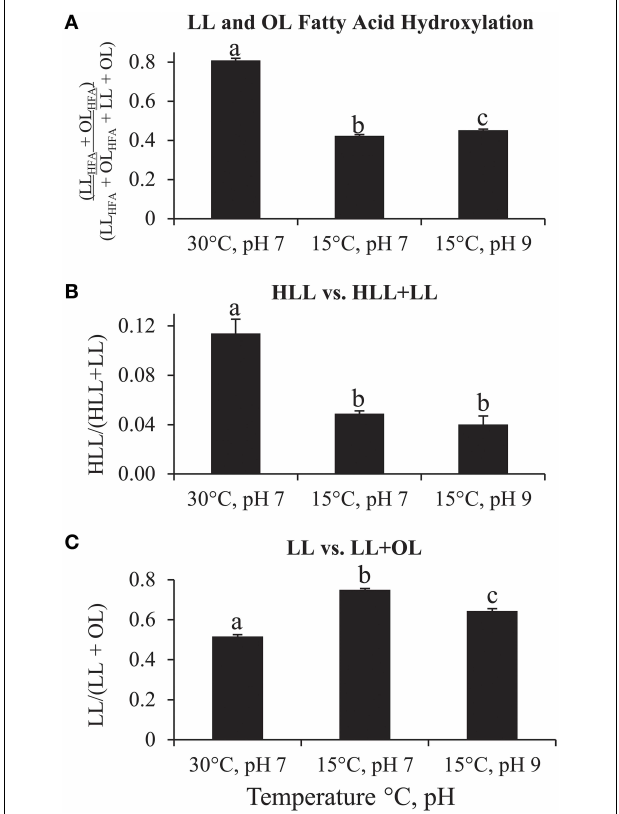
FIGURE 4 | Changes in amino acid-containing IPL abundance ratios based on HPLC-ESI/IT/MS chromatogram base peak area of each lipid group in Pseudopedobacter saltans lipid extract under 30 ◦ C/pH 7, 15 ◦ C/pH 7, and 15 ◦ C/pH 9 growth conditions. (A) Ratio of total fatty acid hydroxylated lysine and ornithine lipids (LL HFA + OL HFA ) to total hydroxylated plus total unhydroxylated fatty acid lysine and ornithine lipids (LL HFA + OL HFA + LL + OL); (B) Ratio of total hydroxylysine lipids (HLL) to total HLL plus total LL; (C) Ratio of total LL to total LL plus total OL. Student’s t -test statistically significant differences ( p < 0 . 05 ) of IPL ratios between different growth conditions are represented by letters (a, b, c) over each bar (different letters represent statistically significant differences between bar graph values within each graph, values with the same letter within each graph are not statistically